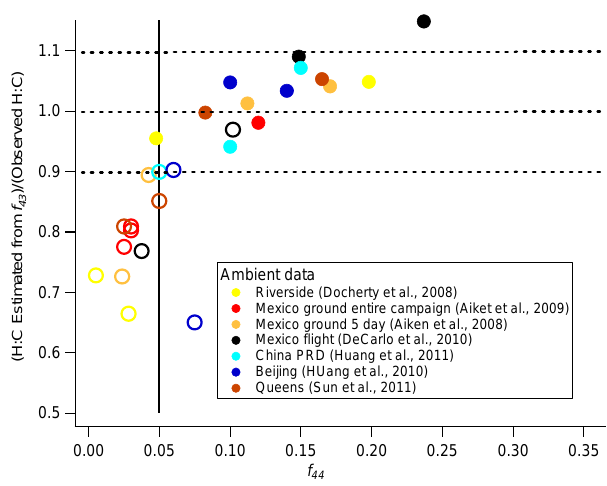
Fig. 3. Ratio of (estimated H:C)/(observed H:C) vs. f 44 for am- bient HR-AMS data (where H:C can be determined directly). The solid circles are OOA components and the open circles are HOA and other primary OA components (local OA, LOA, biomass burning OA, BBOA, and cooking OA, COA). It is clear that for f 44 > 0.05, the parameterization shown in Fig. 2 can reproduce the observed H:C of the OOA components to within ±